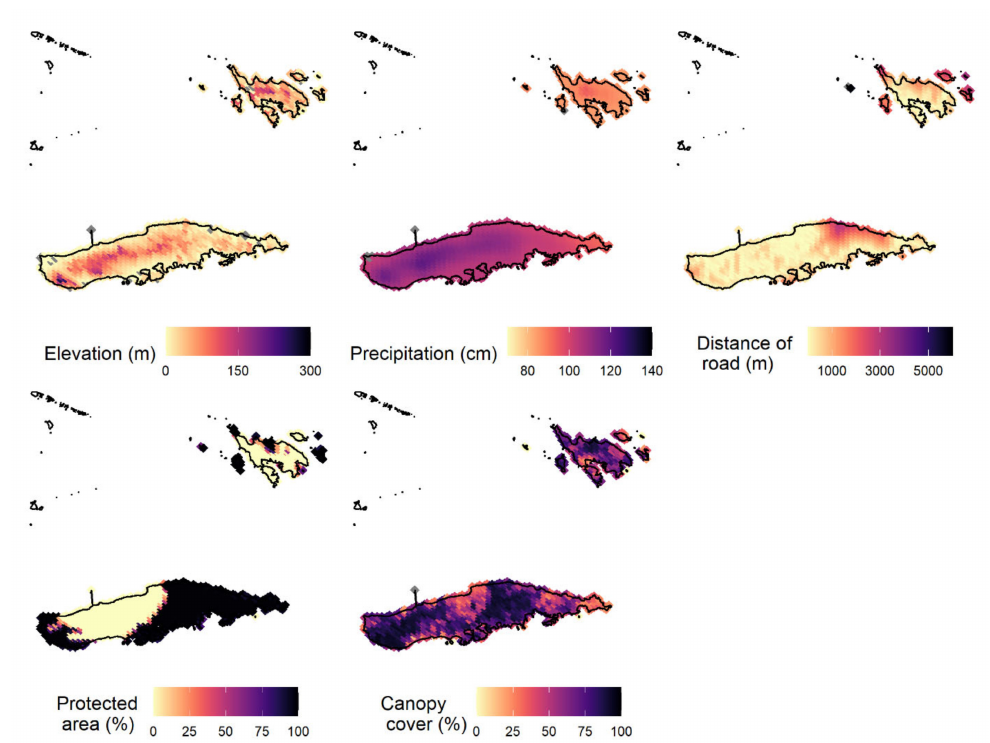
Figure A6. Maps of environmental variables across Vieques and Culebra Islands, Puerto Rico. Top left: elevation; top center: mean annual precipitation; top right: distance of the nearest road; bottom left: proportion of protected area; bottom center: proportion of canopy cover.